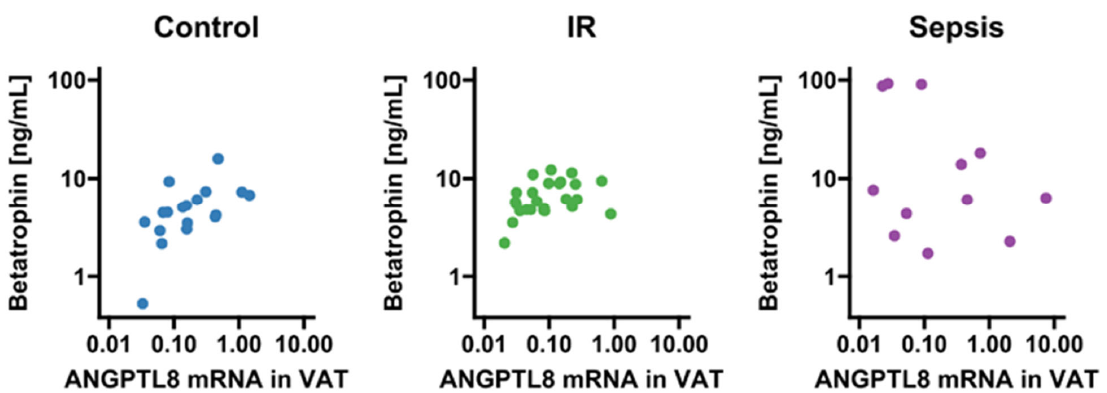
Figure 1. Circulating levels and adipose tissue expression of betatrophin/ANGPTL8. ( A ) Circulating betatrophin/ANGPTL8 was significantly increased in septic ( p = 0.009 after post hoc correction, n = 16) and non-significantly increased in insulin-resistant subjects ( p = 0.053 after post hoc correction, n = 32) as compared to metabolically healthy controls with absent inflammation (n = 18; overall significance according to Kruskal–Wallis p = 0.009). ( B ) Betatrophin/ANGPTL8 gene expression in VAT was comparable between groups (sepsis, n = 13; insulin resistance, n = 32, controls n = 18). IR, insulin resistance; VAT, visceral adipose tissue. Dots are colored according to group identities given on the x-axis. ** p < 0.01 in Kruskal-Wallis test and post-hoc Dunn correction.